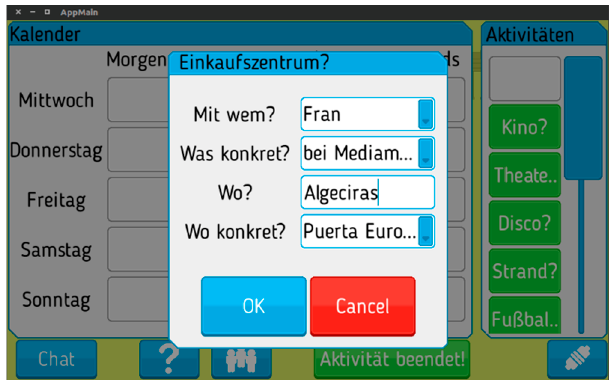
Figure 4. List of activities to do in its digital version.